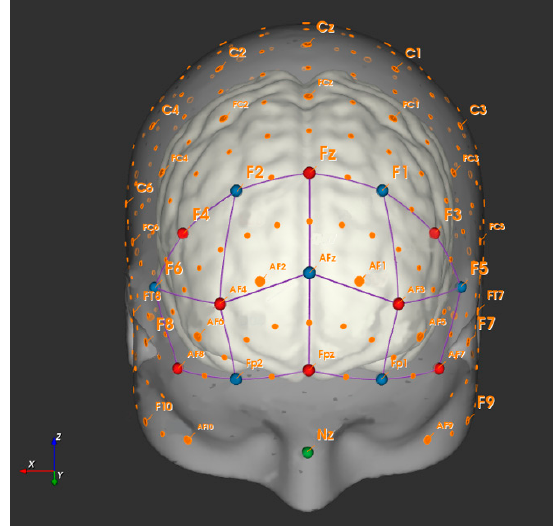
Figure 2. Arrangement of sources (red dots) and detectors (blue dots) at the prefrontal cortex using fNIRS.